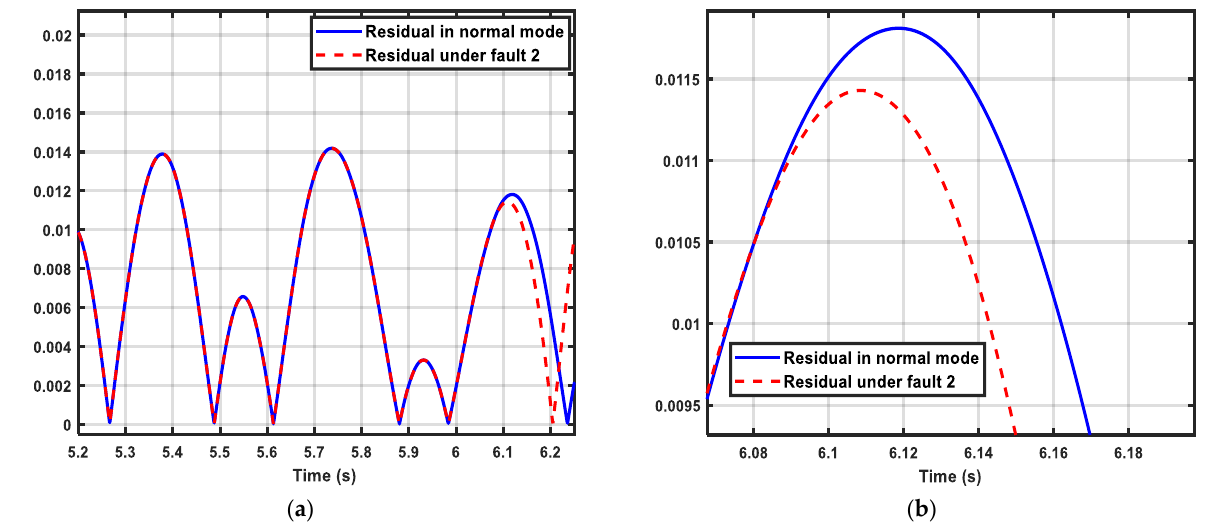
Figure 7. ( a ) Detection of the fault impact on the dynamics of the SG model at T d = 6.089 s, ( b ) zoomed-in view.